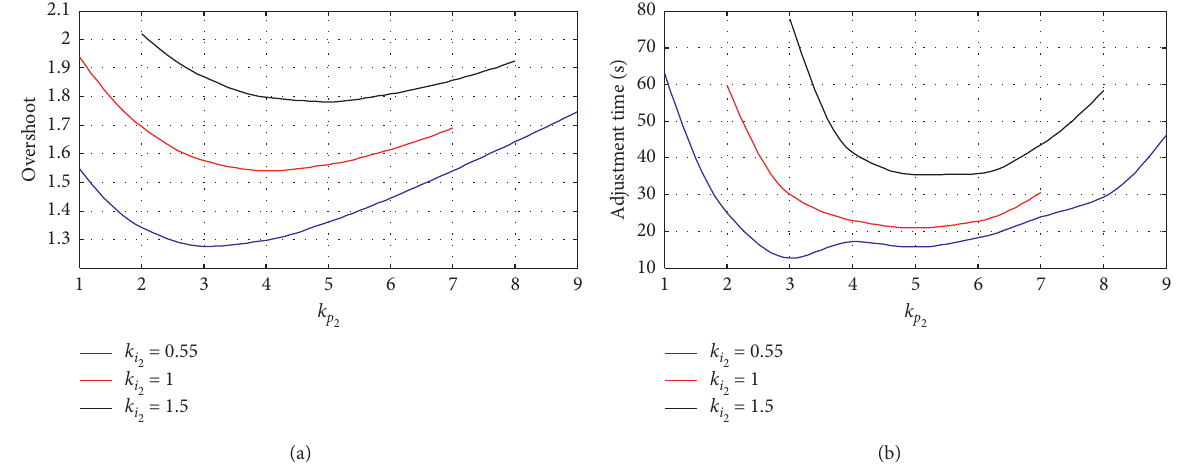
Figure 18: Influence of the k